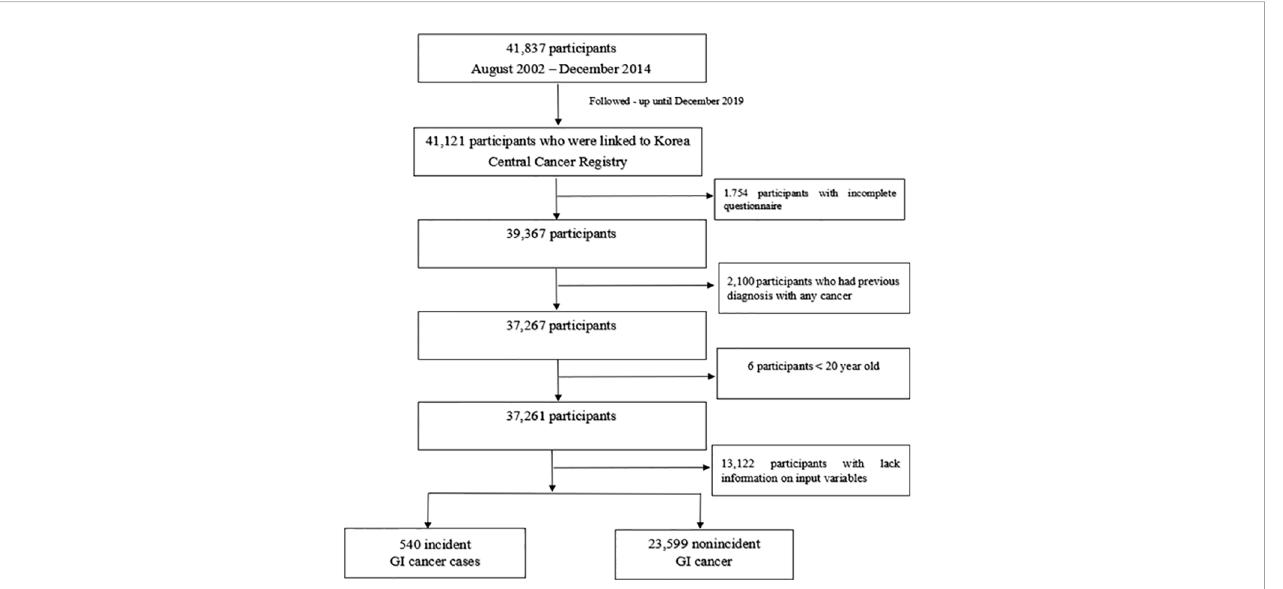
FIGURE 1 Flow chart of the study participants. Among 41,837 participants recruited, 41,121 participants were linked to the Korea Central Cancer Registry. Our fi nal analysis included 24,139 participants after exclusion of 1,754 participants with incomplete questionnaires, 2,100 participants with a diagnosis of any cancer before recruitment, 6 participants aged <20 years, and 13,122 participants who lacked information on individual